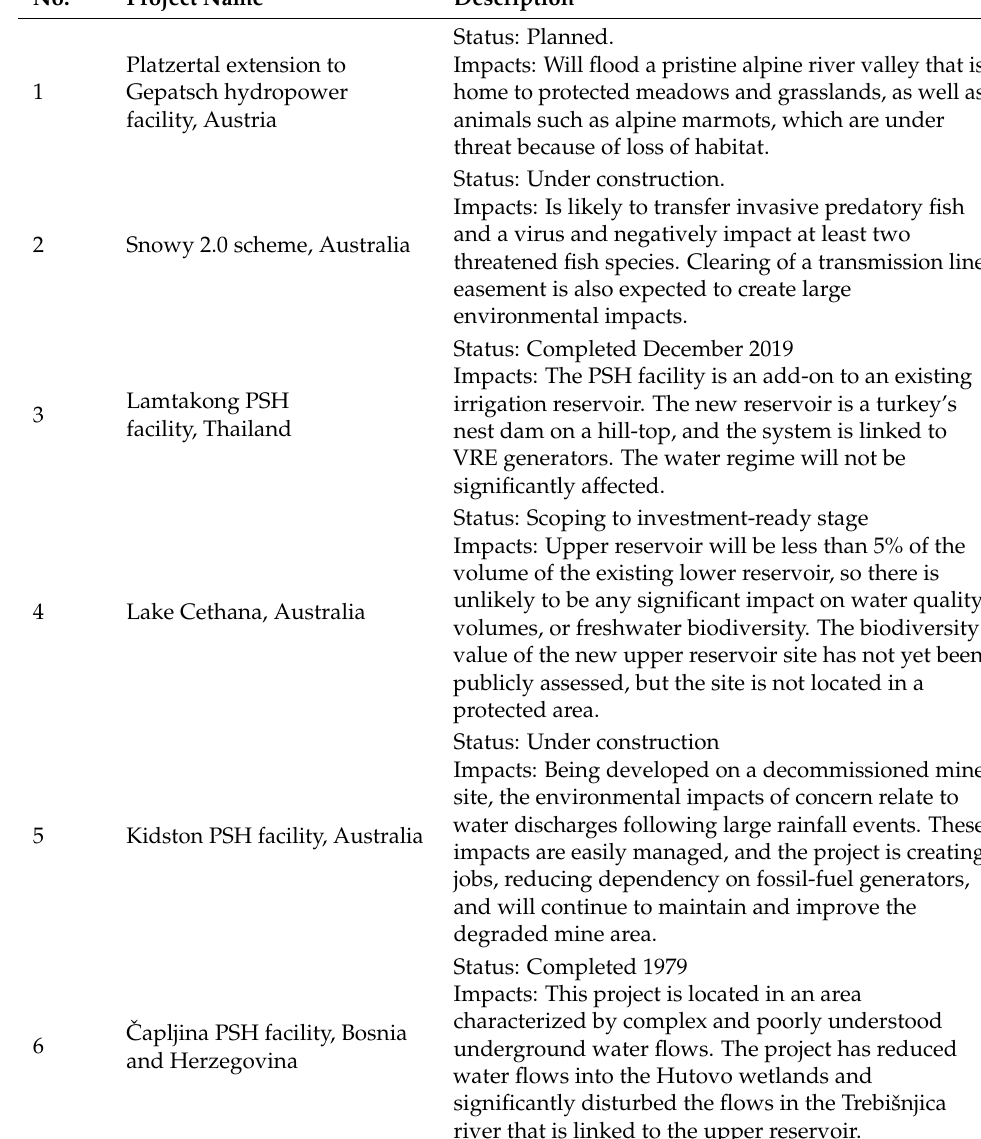
Table 2. Six case studies of PSH projects (Source: